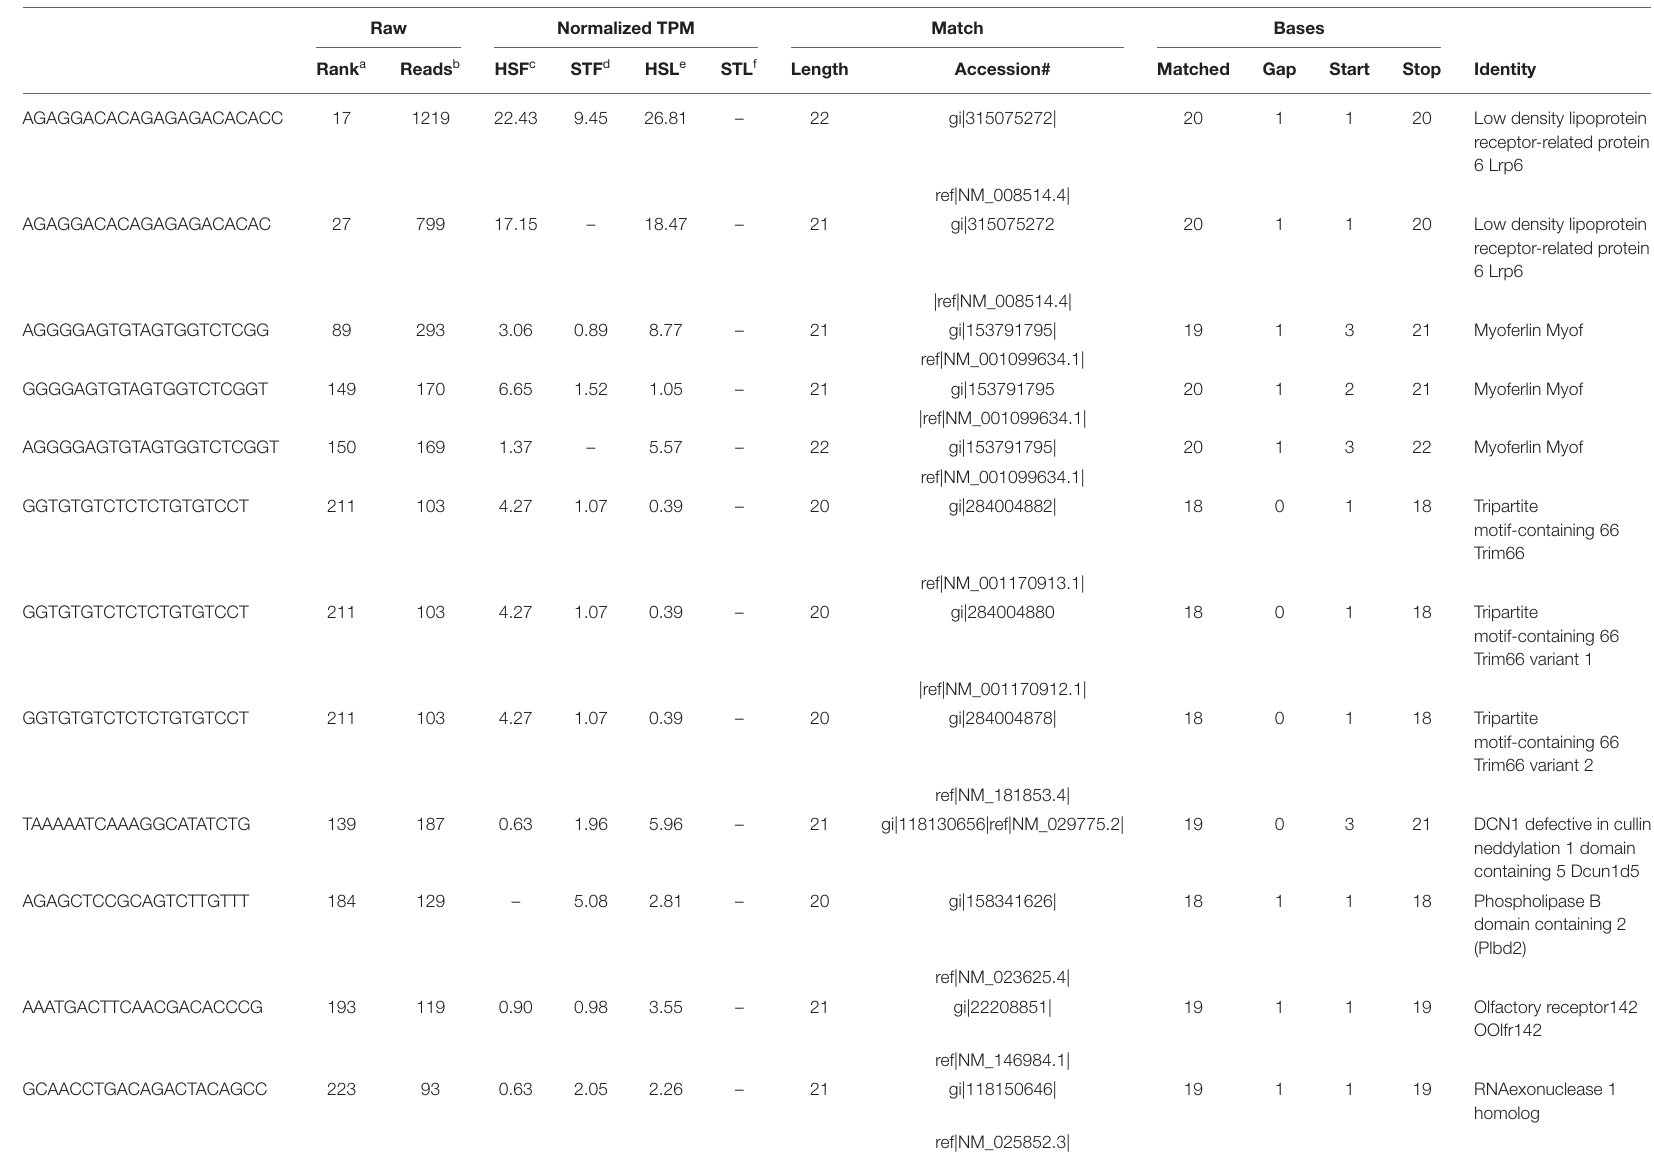
TABLE 3 | PPV-CP sRNAs best match Mus musculus